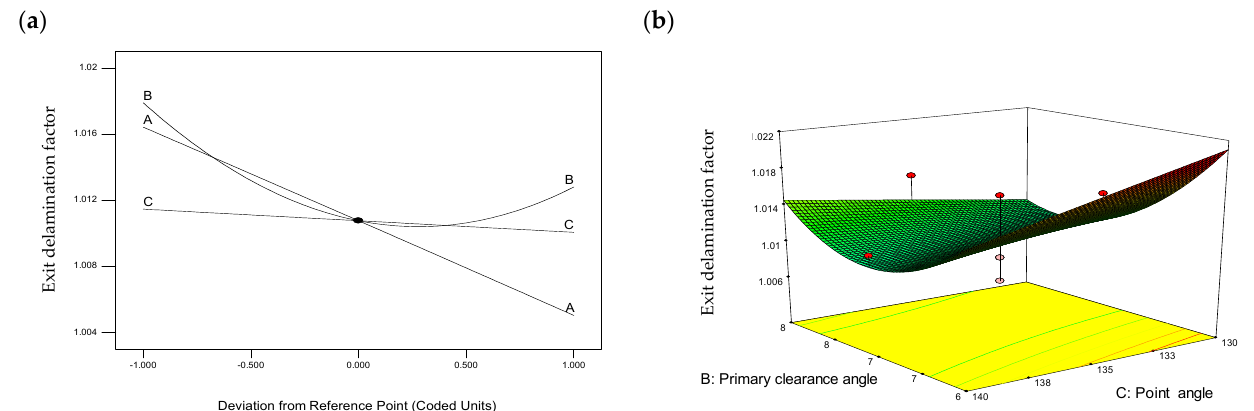
Figure 11. ( a ) Perturbation plot and ( b ) 3D Response surface for exit delamination of CFRP. A, chisel edge angle; B, primary clearance angle; C, point angle.